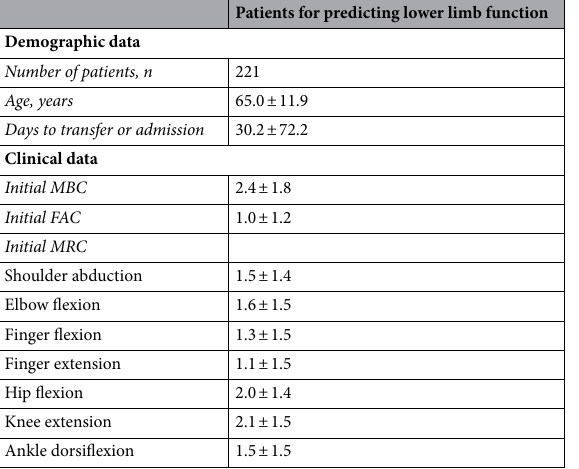
Table 1. Patient demographic and clinical data collected on the day of transfer or admission to the rehabilitation department. MBC modified Brunnstrom classification, FAC functional ambulation category, MRC medical research